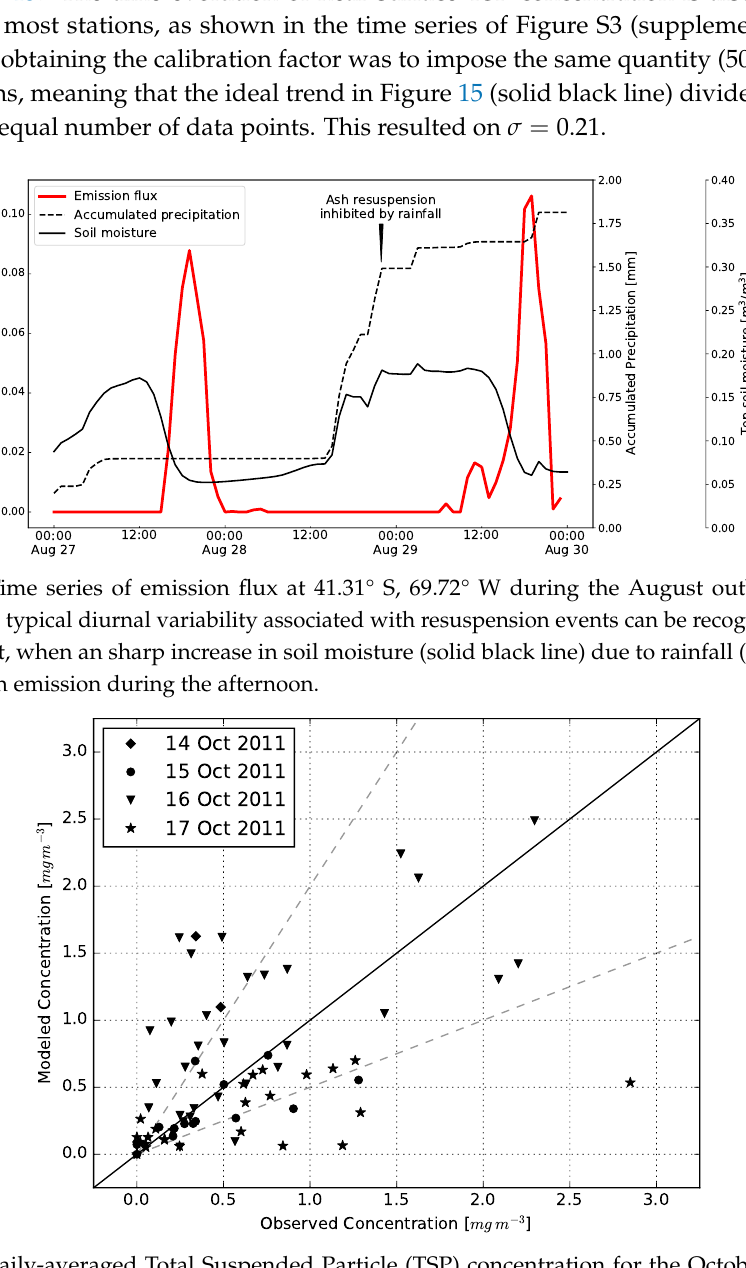
Figure 15. Daily-averaged Total Suspended Particle (TSP) concentration for the October outbreak. Observed concentration was derived from visibility reports at 43 weather stations. The emission scheme was calibrated to simulate concentration considering an erodibility parameter of 0.21, representing a calibration factor for the theoretical emission flux. Dashed lines indicate a 1:2 ratio between model and observations, the perfect agreement is represented by the solid black